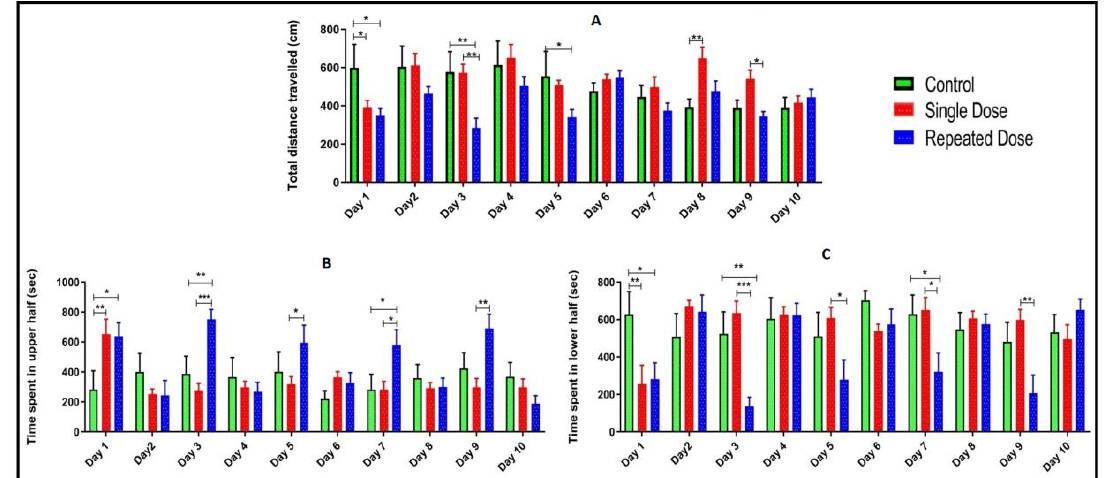
Figure 4. Total distance travelled, time spent in upper and lower half of the tank. All the values are expressed as mean ± SEM, and each data point shows the average of ten fish in each group ( n = 10). Statistical analysis was carried out using two-way ANOVA, p < 0.05 was considered significant, * p < 0.05, ** p < 0.01, *** p < 0.001. Total distance travelled in a tank ( A ), time spent in upper half ( B ), and time spent in lower half ( C ).